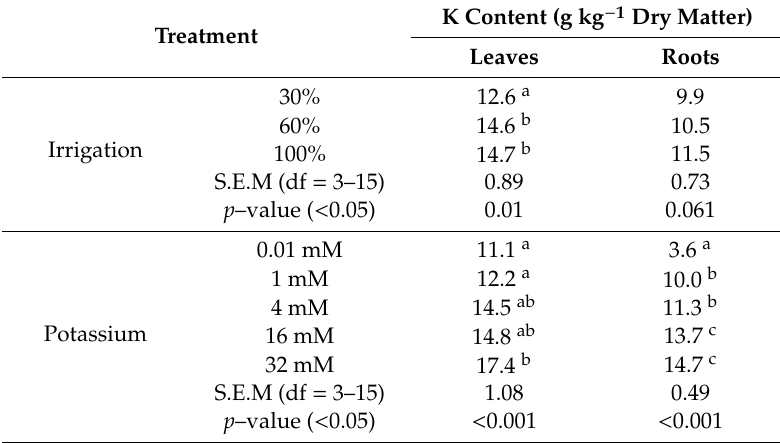
Table 4. Potassium (K) content in the leaves and roots of 90-day-old cassava plants in four pot experiments. Deficit irrigation and K fertigation were initiated 30 days after planting and lasted 60 days. The data from separate experiments were combined and shown as the means of 4 to 16 replicate